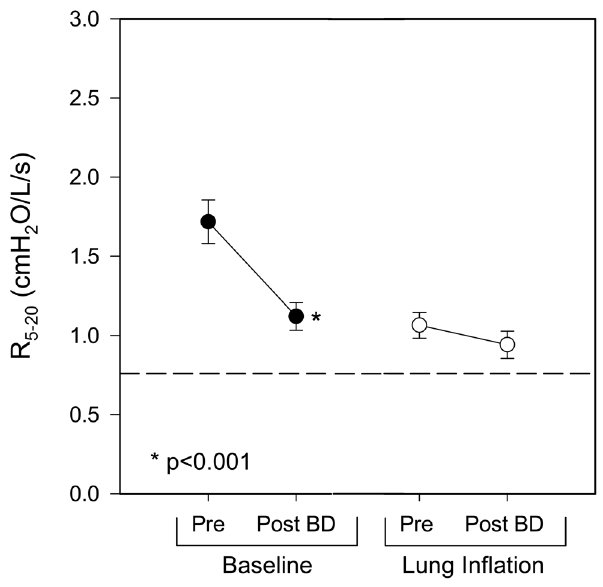
Figure 6. Effect of bronchodilator administration on R 5 2 20 at baseline and during voluntary inflation to predicted FRC. Data N are mean 6 SE. Dotted line represents the upper limit of normal. =baseline # =voluntary (